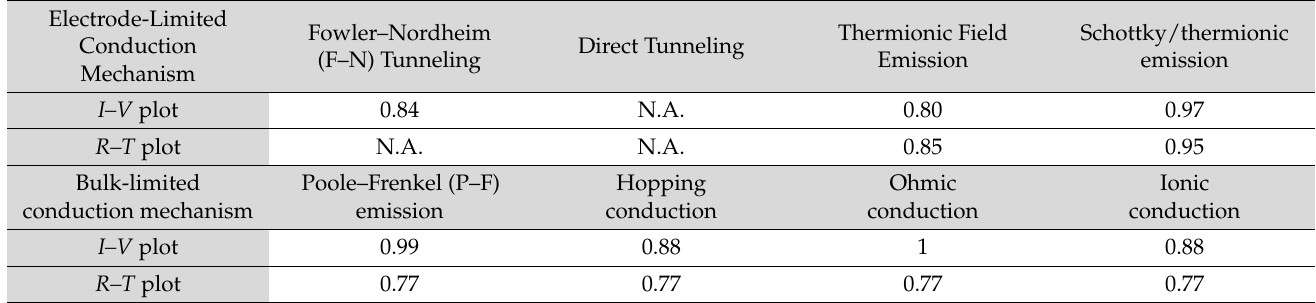
Table 2. R 2 values when curve-fitted with other conducting